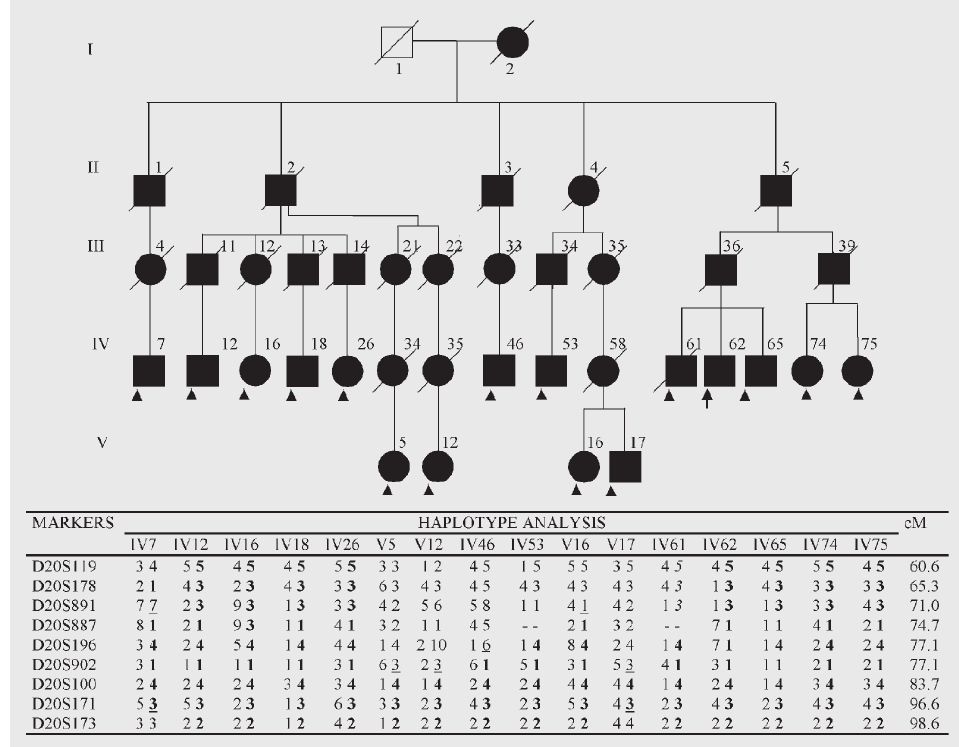
Figure 1. Haplotype analysis of the affected family members. The haplotypes associated with the disease are in bold. Recom- bination events are identified by horizontal bars that delineate the involved area of chromosome 20q13.2-20q13.3.